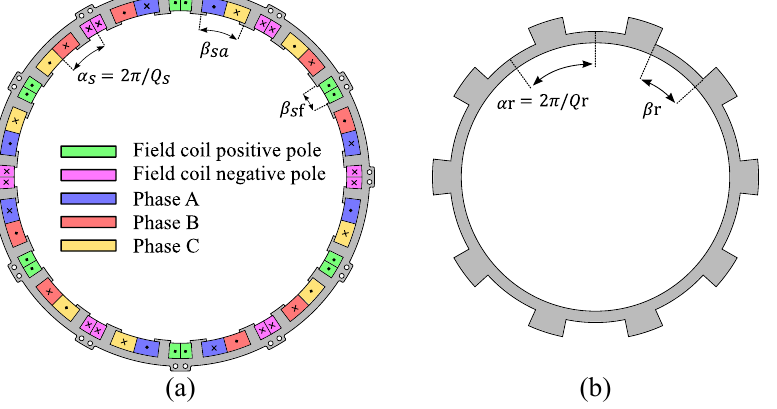
Figure 1. Cross-section of the base geometry used on this paper: ( a ) stator with field and armature windings, and ( b ) salient pole